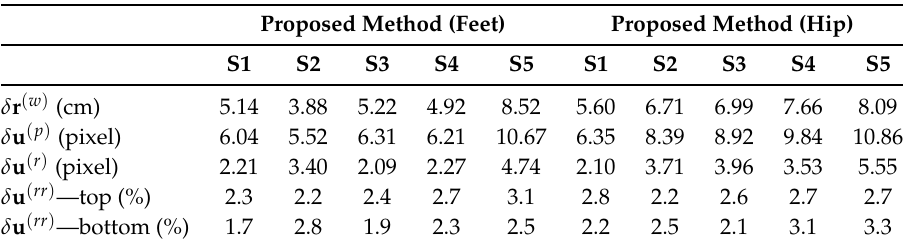
Table 8. Calibration results of camera calibration based on single person of the Camera Network 4. relative reprojection error, respectively.